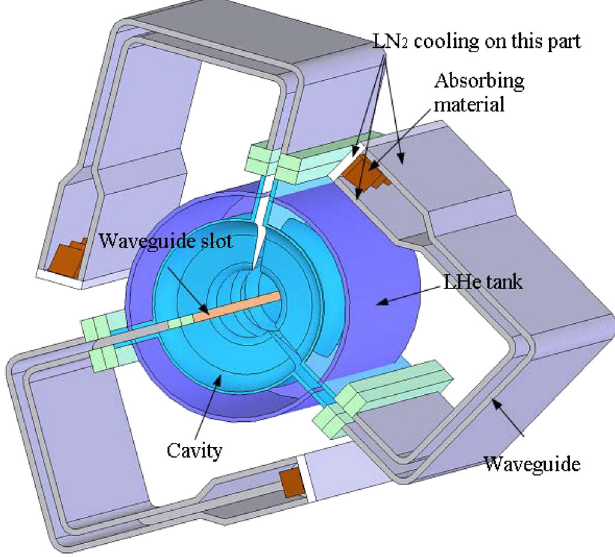
FIG. 11. (Color) Slotted cavity with waveguide